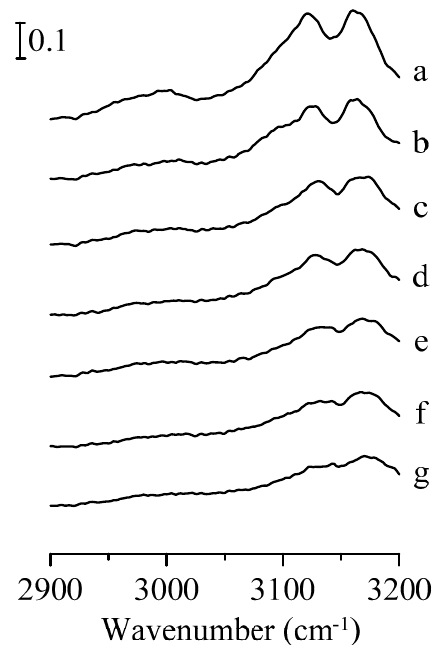
Figure 4. Infrared spectra of pure 1-ethyl-3-methylimidazolium trifluoromethanesulfonate obtained under ambient pressure (curve a) and at 0.4 (curve b), 0.7 (curve c), 1.1 (curve d), 1.5 (curve e), 1.8 (curve f), and 2.5 GPa (curve g).